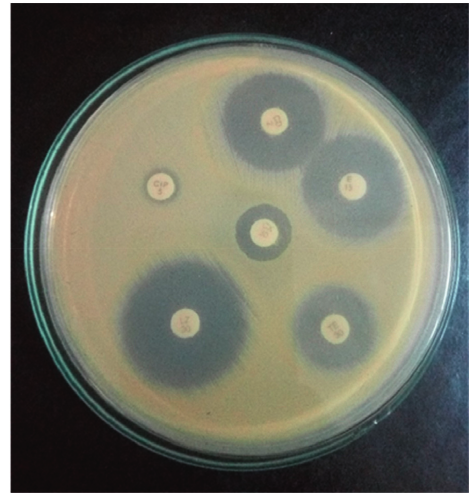
Figure 2: Antibiotic susceptibility pattern of MRSA.